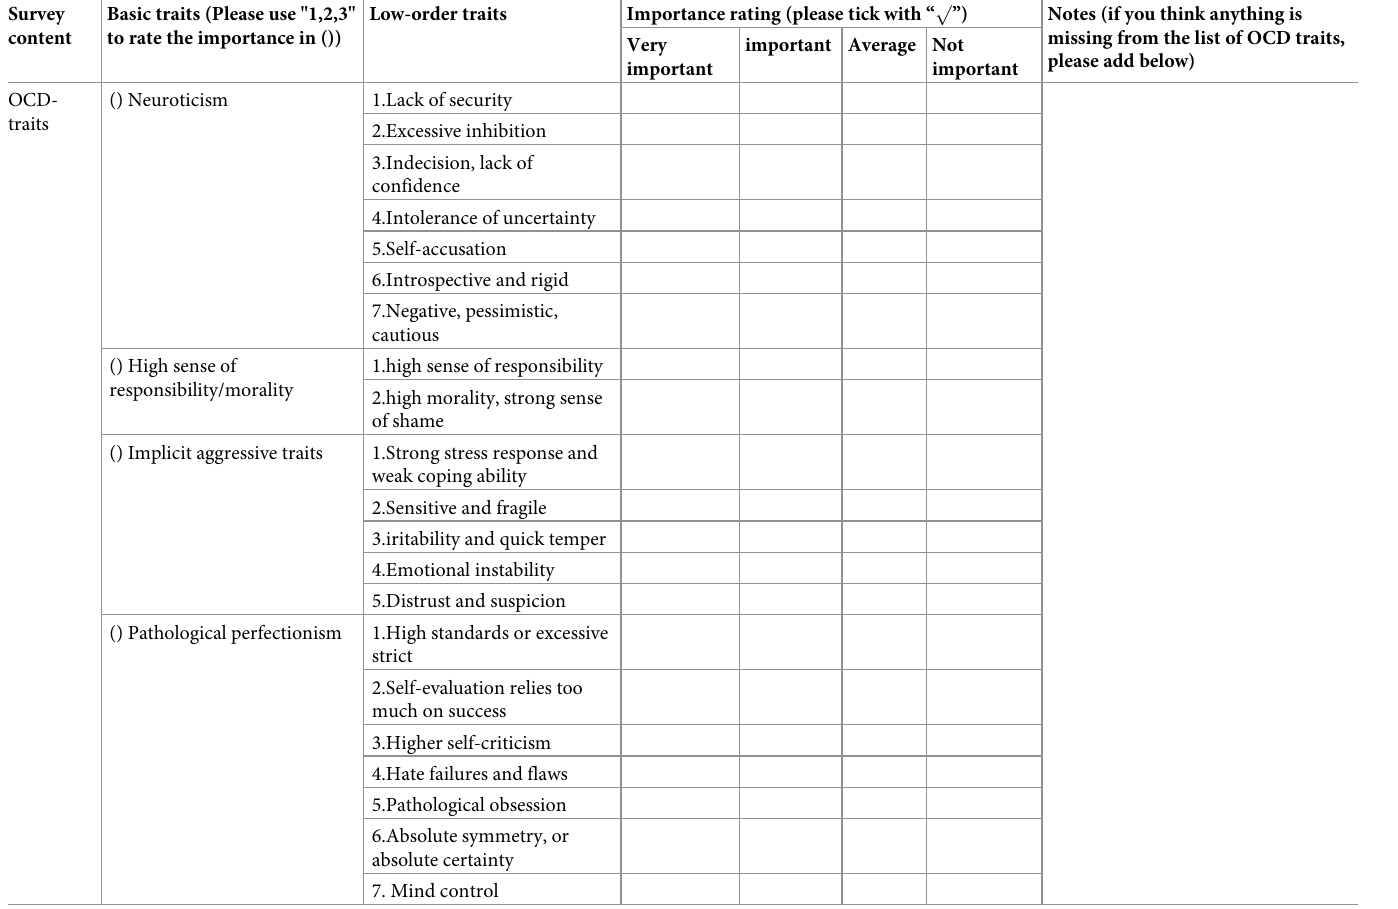
Table 2. Two-way specification table used for the study of OCD-traits. Survey